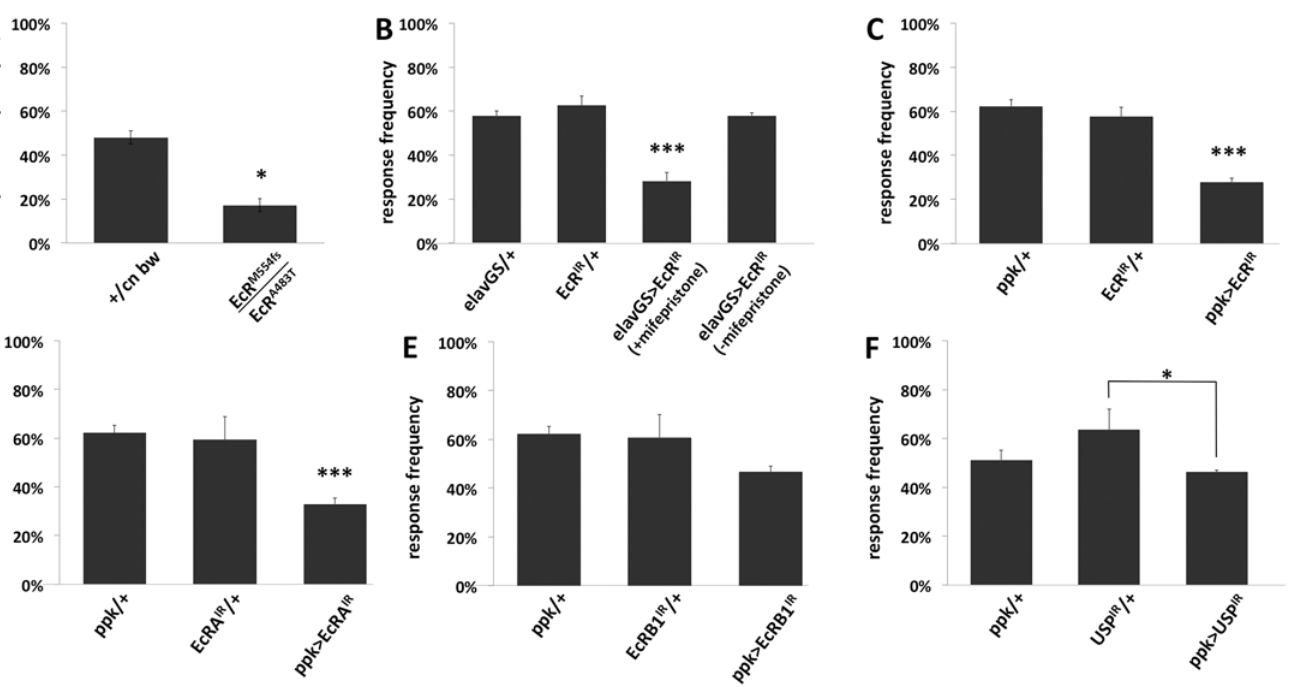
Fig 3. Ecdysone receptor mutants are less sensitive to noxious mechanical stimulation. Foraging third instar larvae were stimulated on their dorsal surface with a von Frey filament calibrated to deliver 45 mN. Larvae responding with a nocifensive roll were classified as responders. Distributions were compared with Fisher ’ s exact test. Asterisks indicate statistically different groups ( * is p < 0.05, *** is p < 0.001). N > 90. (A) Mutants bearing one null allele of EcR (EcR M554fs ) and one temperature sensitive allele (EcR A483T ) were significantly less sensitive than controls comprising the genetic backgrounds of each mutation (+ = Canton-S). (B) EcR RNAi is driven by the mifepristone-inducible neuron-specific elav-Geneswitch. (C-F) Various EcR and a USP RNAi are driven by ppk1.9-Gal4, specific to the nociceptive class IV multidendritic neurons.